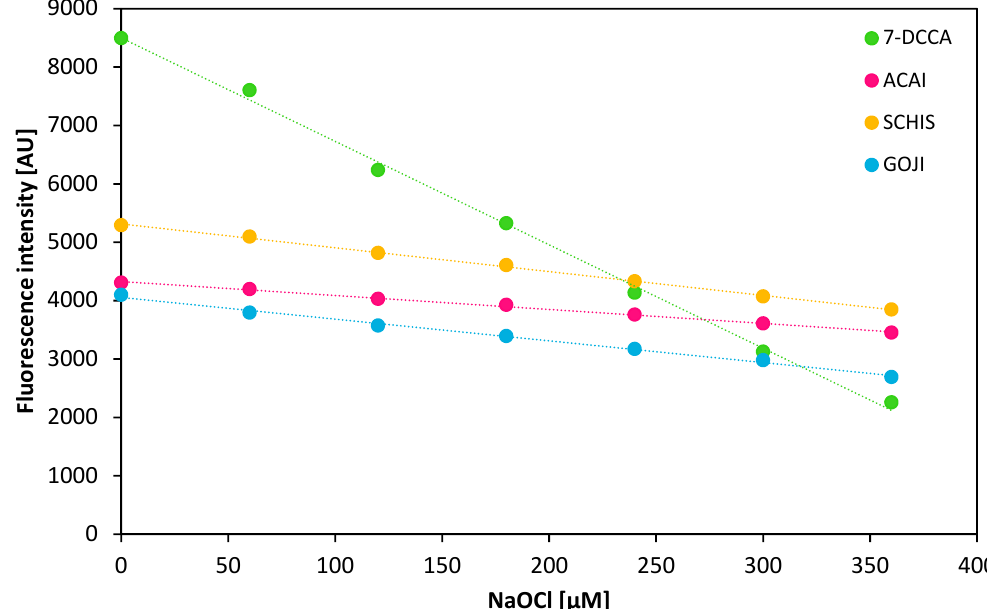
Figure 5. The decrease in fluorescence intensity of 150 µ M of the 7-DCCA probe ( λ Ex 289 nm, λ Em 460 nm) in the presence of the aqueous berry extracts (4 mg / mL) incubated with increased concentrations of NaOCl for 15 min at pH 7.4.